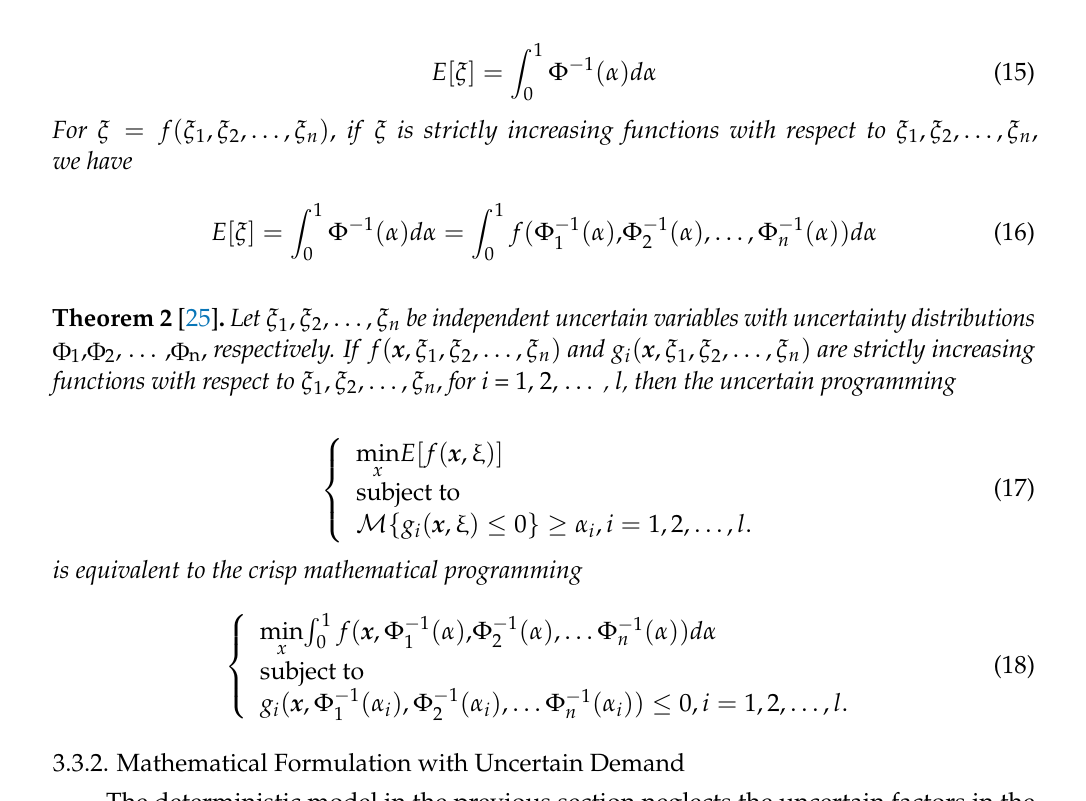
c 0 Figure 3. Zigzag uncertainty distribution. Theorem 1 [25] .